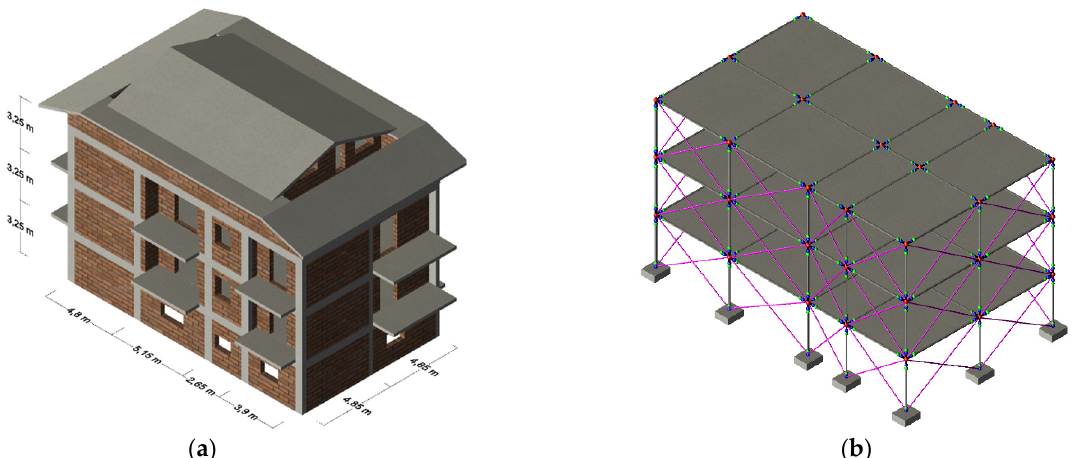
Figure 4. Case-study building ( a ) solid view and ( b ) finite element model (adapted from Gaetani d’Aragona et al. [68,69]).